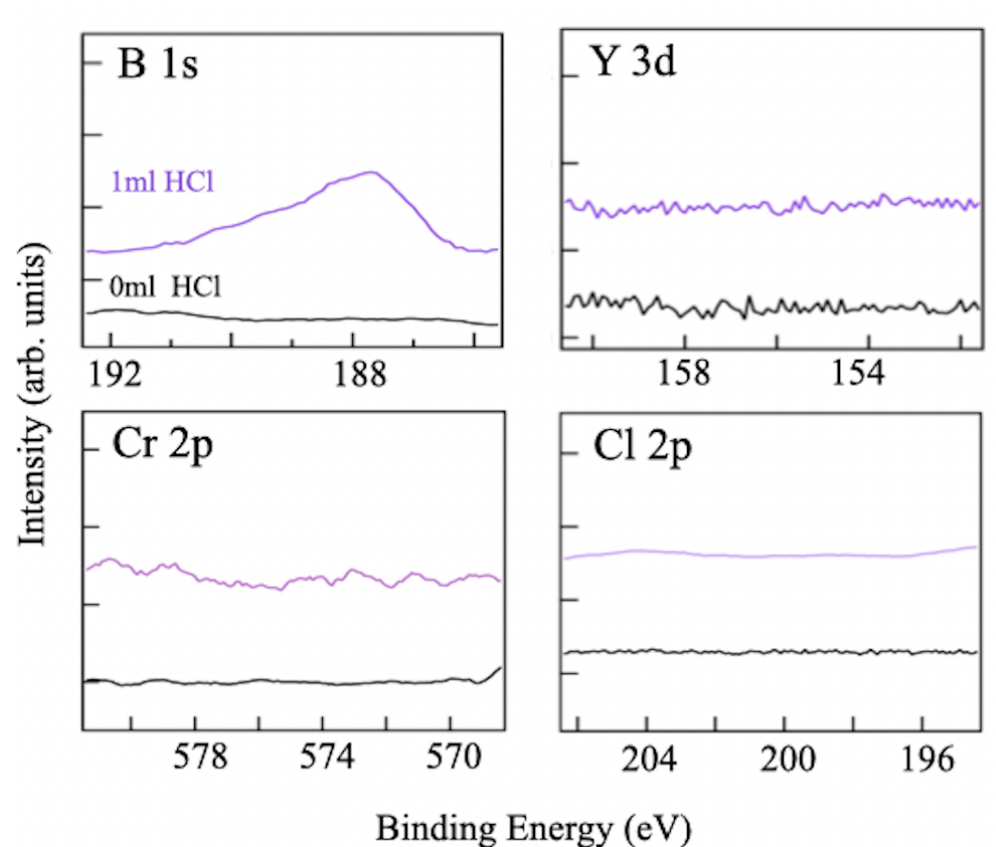
Figure 7. Collection of XPS spectra (purple curves) at the binding energy regions of B 1s, Y 3d, Cr 2p, and Cl 2p core levels for the filtrate sample after three days of reaction with hydrochloric acid (1 mL HCl). For comparison, the individual figures contain the XPS spectra (black curves) of the sample, prepared using the conventional method without hydrochloric acid (0 mL